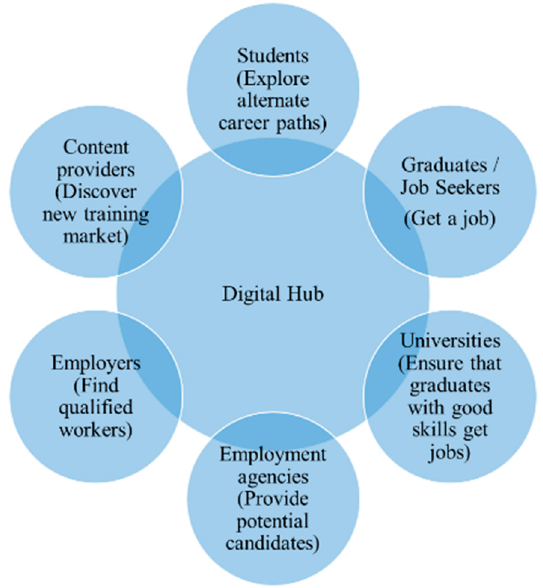
Figure 6. Using a digital hub to connect various actors.